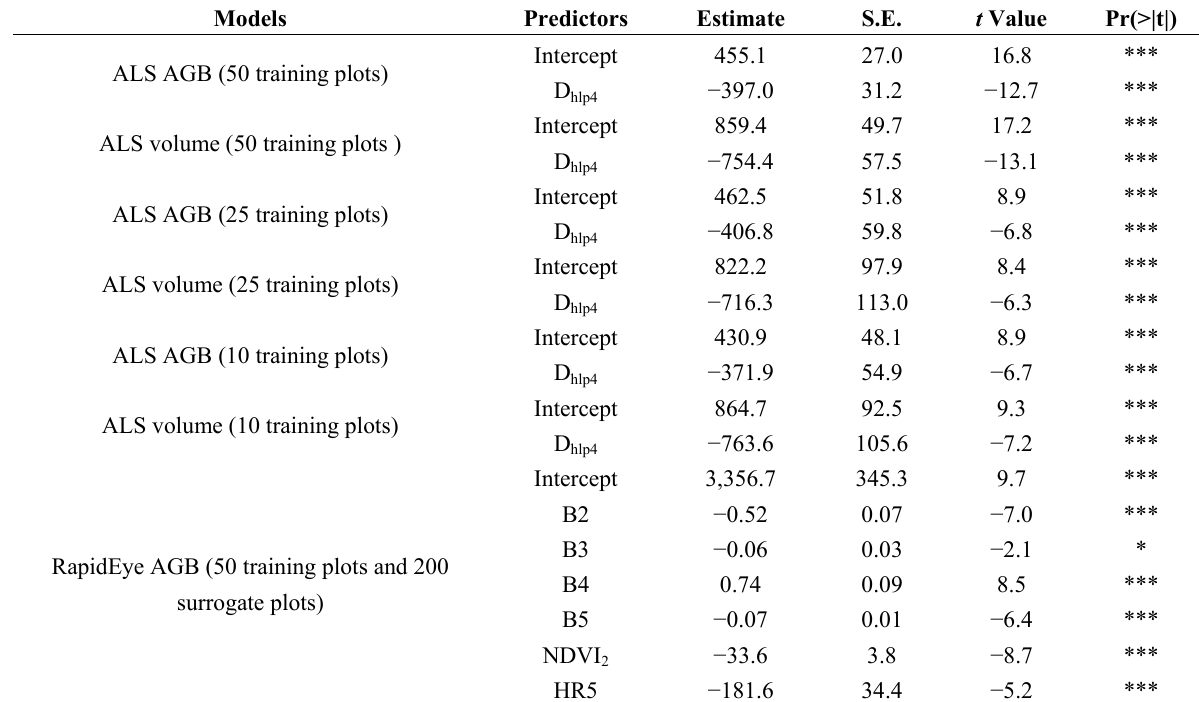
Table A1. Explanatory variables in each